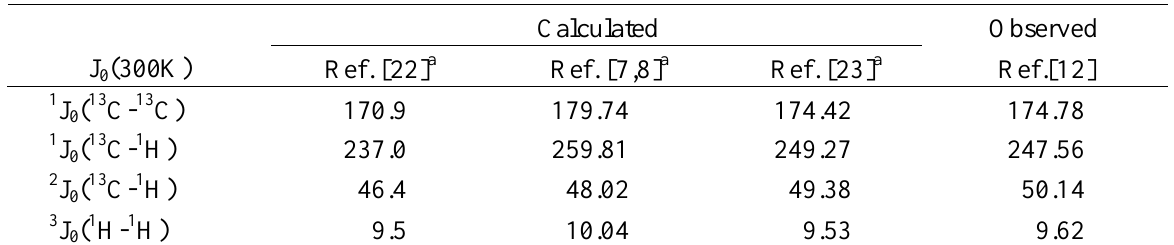
Table 4. Comparison of calculated and observed spin-spin coupling constants [Hz] for 1,2- 13 C- acetylene at 300